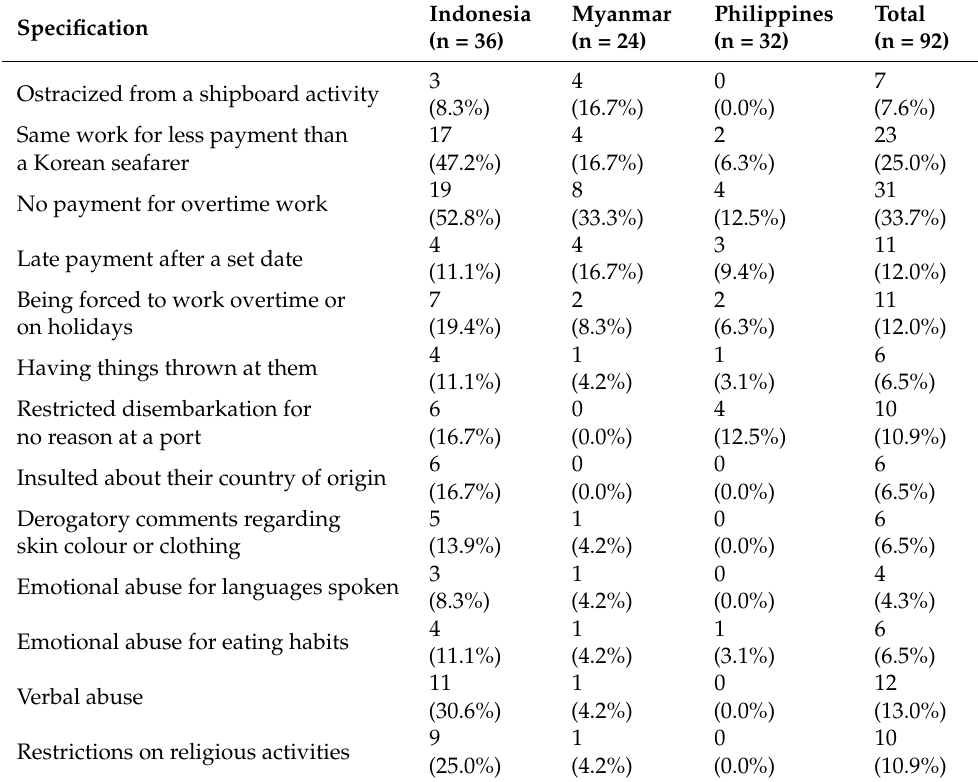
Table 3. Forms of discrimination experienced by foreign seafarers by